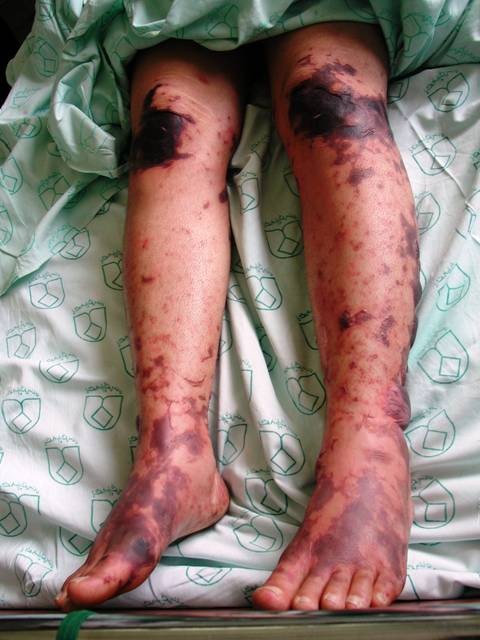
Hemorrhagic bullae on the 3rd day of antibiotic therapy.